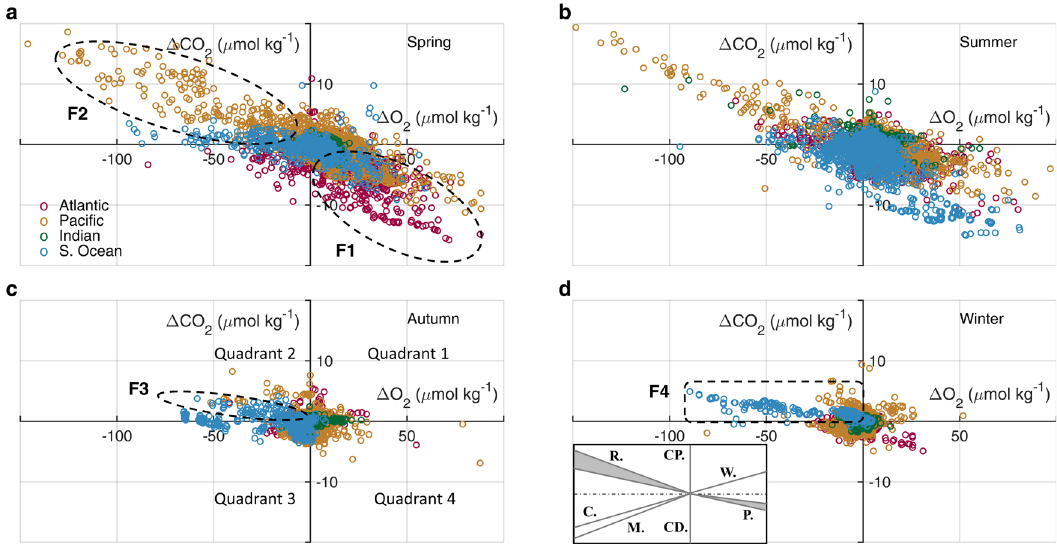
Fig. 2 CORS plots: Carbon dioxide and oxygen concentrations relative to saturation in the global surface ocean in four seasons. a Spring, b summer, c autumn, and d winter. Note the different axis scales for CO 2 and O 2 . The inset in ( d ) shows the predicted effects of different processes (see “ Methods ” ) on Δ CO 2 and Δ O 2 : warming (W), cooling (C), ice melt (M), photosynthesis (P) and respiration (R), calcium carbonate precipitation (CP) and dissolution (CD). Gray shading shows the range of the P and R slopes for temperatures between 5 °C and 15 °C. The inset is proportional to the four subplots for directly comparing the slope of the processes in the inset with those in the